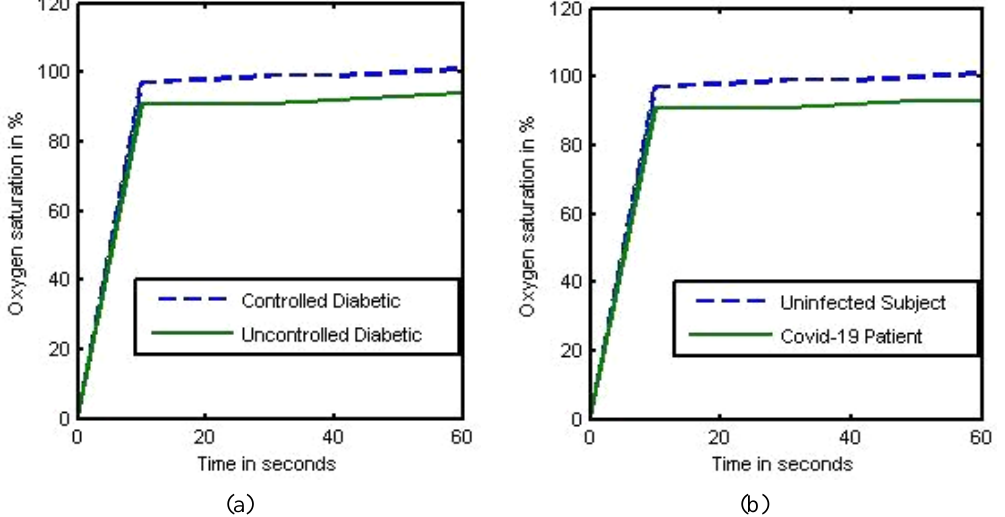
Figure 10. (a) Controlled diabetic versus uncontrolled diabetic, and (b) COVID-19 patient versus uninfected subject